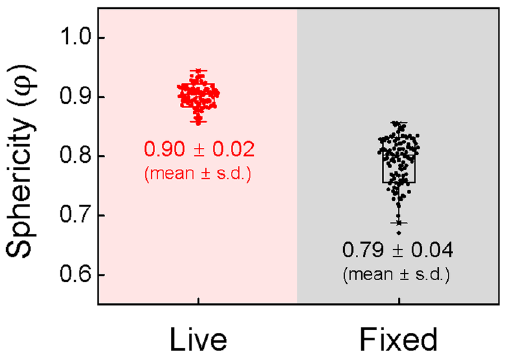
Figure 2. Sphericity of 120 alveoli in the live lungs and 120 alveoli in the fixed lungs. ϕ is the sphericity of individual alveoli ( ϕ of the sphere = 1). ϕ = 0.90 ± 0.02 (mean ± s.d.) for the live lungs and ϕ = 0.79 ± 0.04 (mean ± s.d.) for the fixed lungs were taken from x-ray microtomography ( P -value = 2.8 × 10 –67 ). Every single measurement is not from the same alveolus.